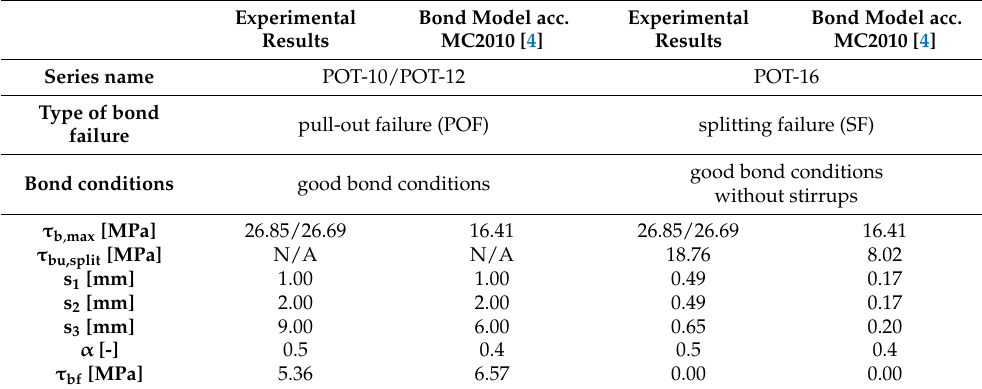
Table 12. Summary of characteristic point values of the bond stress–slip curves.